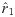
The edge correction.Variation of the Jones edge correction, E, for different combinations of wing aspect ratio and area centroid location. The wing planform is represented through the beta formulation (Eqs 17 and 18) for r^1 values from 0.4 to 0.6 which is representative of the range found in nature. In this illustration, the wing is symmetric about the mid-chord.